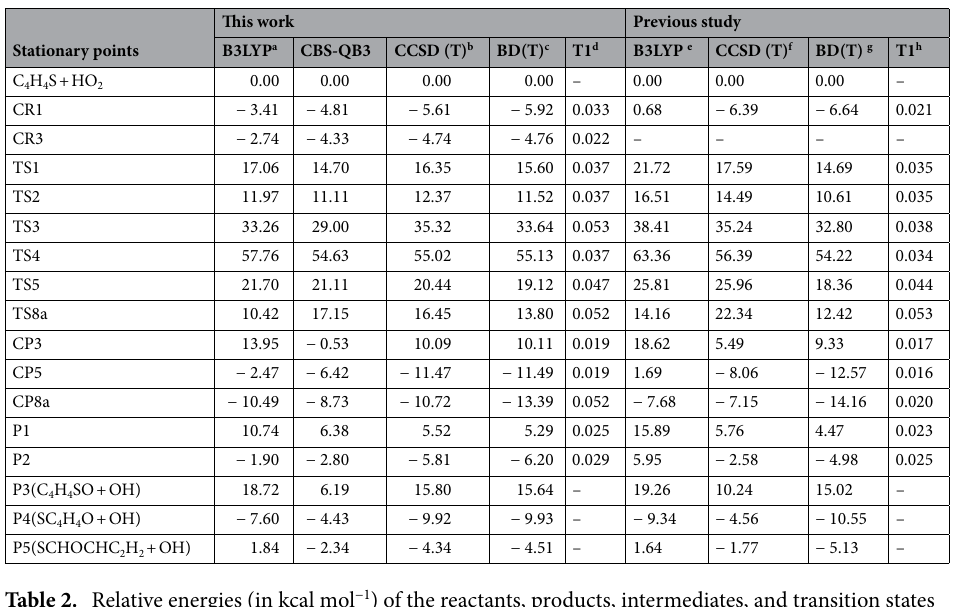
1WTB1, are produced. The obtained product complexes have ring structures as well, which are confirmed by an AIM analysis. CP-TS1-1WHA1 has a five-membered ring structure with ρ( rcp ) = 0.0138 e bohr −3 and 2 ρ( rcp ) = 0.0707 e bohr −5 . And, CP-TS1-1WTB1 includes a six-membered ring structure with ρ( rcp ) = 0.0062 ∇ CP-TS1-1WTB1 is in accord with the P1 and water formation as final products. The thermodynamic parameters of P1 are ΔH 0 = 6.49 kcal mol −1 and ΔG 0 = 17.47 kcal mol −1 . According to Tables S14 and S15, the Fukui values for radical addition of the O12 atom of hydroperoxyl radical to the C2 center of thiophene are − 0.535 and − 0.090 e in reactant species, respectively. These values are − 0.047 and − 0.126 e in TS1-1WHA and − 0.048 and − 0.139 e in TS-1WTB, respectively. A decrease in the value of f 0 X (X = O and C) from reactants to the TSs is related to the formation of a covalent bond. This means that after the formation of a covalent bond between the reacting centers, the reactivity of these centers is decarded. In the sequel, the reaction can be continued by the TS5-1WHA and TS5-1WTB saddle points. Firstly, without any barrier, the CP-TS1-1WHA1 and CP-TS1-1WTB1 can rearrange to the intermediate complexes CP-TS1- 1WHA2 and CP-TS1-1WTB2, respectively. After that, an epoxy structure can obtain if the oxygen–oxygen bond of HO